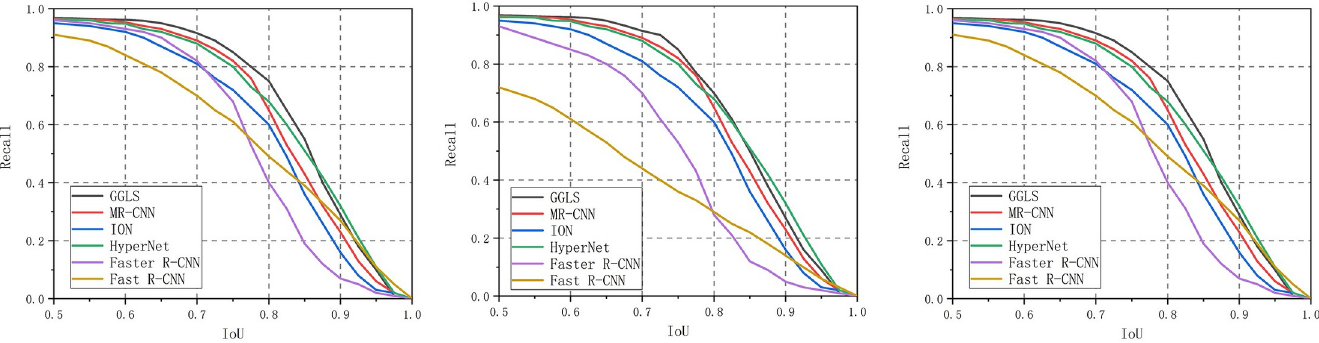
PLOS ONE | https://doi.org/10.1371/journal.pone.0251339 May 13,